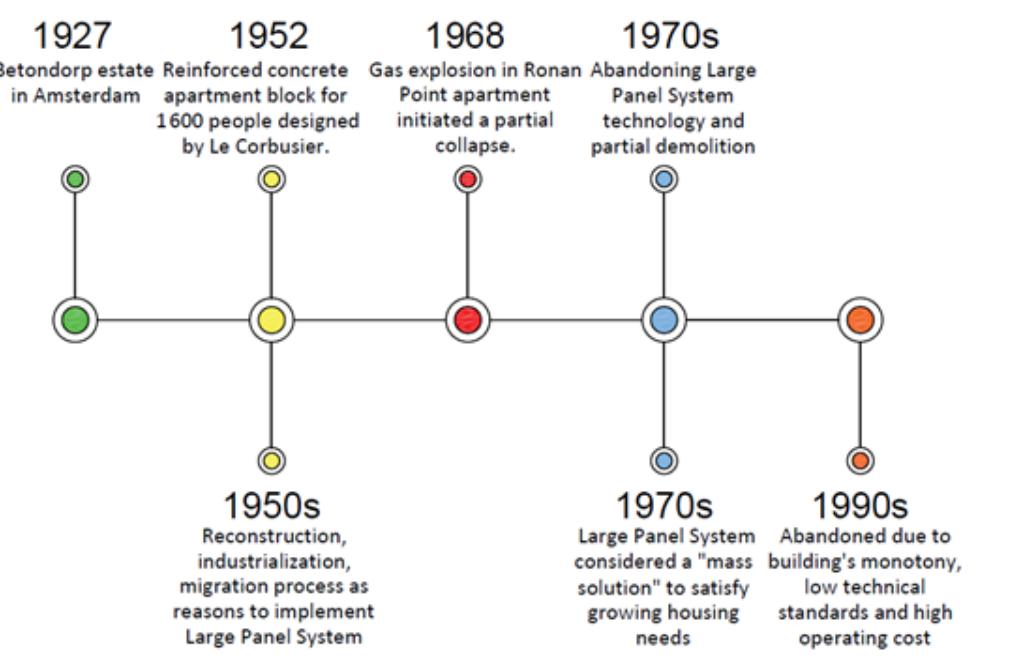
Figure 6. The most important dates from history of large panel system technology with a) Western Europe b) Eastern Europe—Polish example (based on information provided in [36–41]).